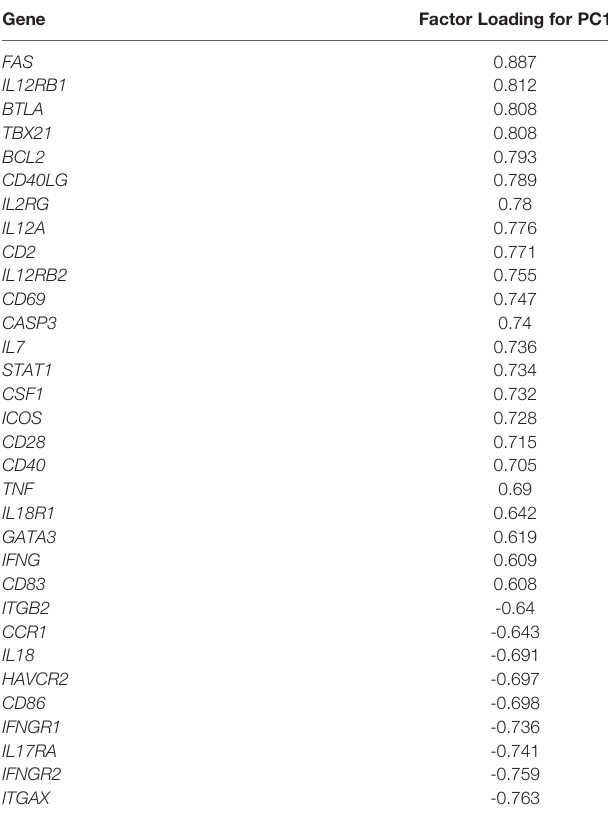
TABLE 2 | Genes with factor loading of principal component 1 (PC1) higher than 0.6 or lower than -0.6 obtained in the principal component analysis (PCA) including IND and HD